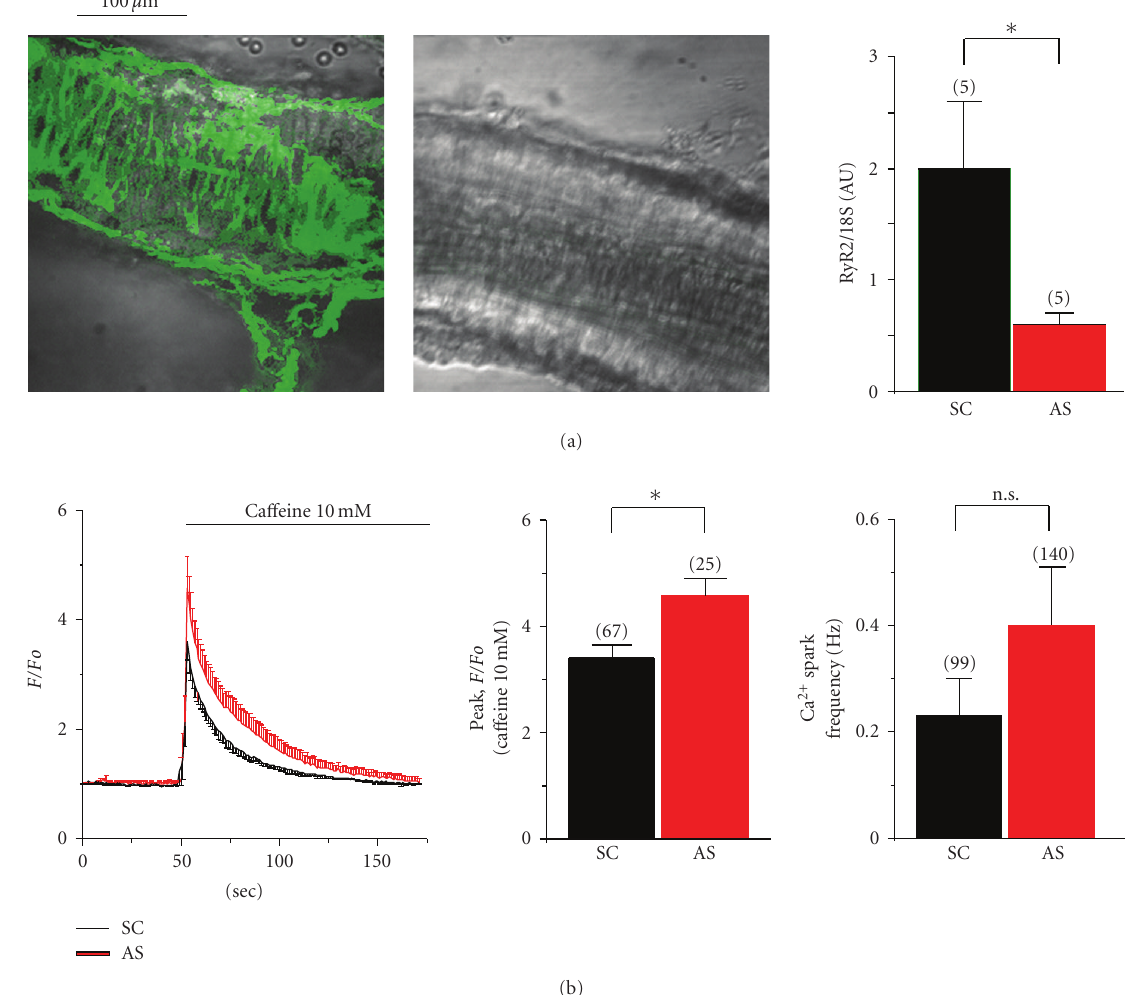
Figure 3: In vivo suppression of RyR2 expression by a ntisense oligonucleotides (AS ODNs) in rat cerebral artery smooth muscle cells leads to increase of SR Ca 2+ content without e ff ects on spontaneous calcium sparks . (a) Left side: Images of rat cerebral arteries isolated 7 days after continuous i.c.v. injection of the fluorescence-labled AS ODNs (left) and nonlabeled AS ODNs (right) via Alzet osmotic pumps. Right side: RyR2 mRNA expression normalized to 18S ribosomal mRNA expression in arteries isolated from rats treated by AS ODNs (red) and scrambled (SC) ODNs (black) ( n = 5 rats in each group). (b) Left side: Averaged time course of changes in response to external 10mM ca ff eine in fluorescence intensity in Fluo-4 loaded cerebral artery smooth muscle cells (SMCs) isolated from rats treated with AS ODNs (red) and SC ODNs (black). The corresponding mean peak amplitudes are presented in the middle plot. Right side: The frequency of calcium sparks was not di ff erent between AS and SC ODNs treated cells. Calcium sparks were recorded in line-scan mode. The number of cells tested is indicated above each bar. Data are mean ± S.E.M. AU: arbitrary